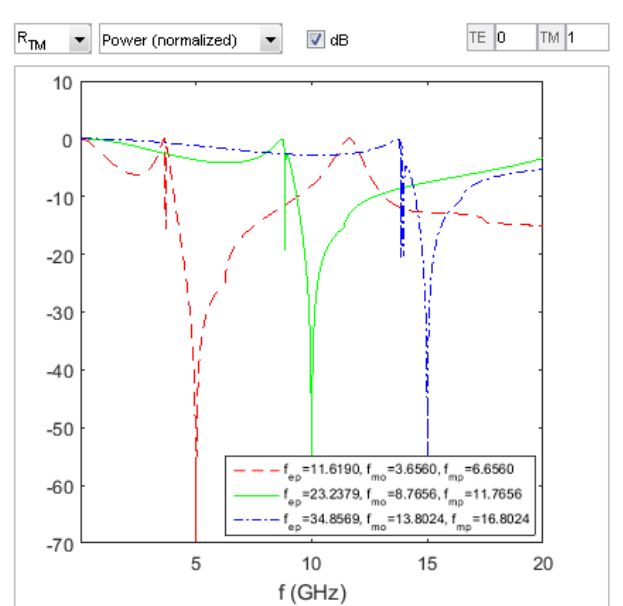
Figure 4: Reflectance of wave with TM polarization and angle 45 o from a dispersive DPS-DNG bilayer structure with different dispersion parameters given in the legend (in GHz) in terms of dB